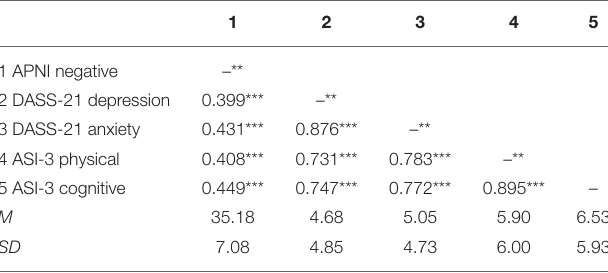
TABLE 1 | Mean, standard deviation, and correlation coefficient of each